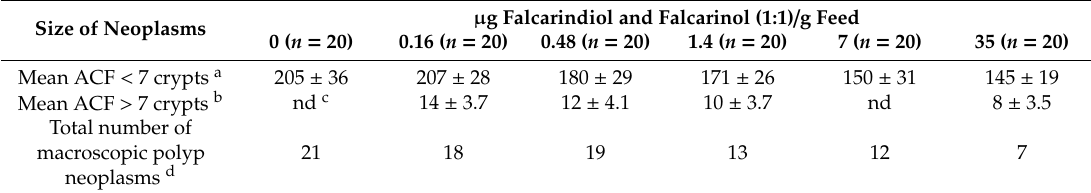
a Significant dose-response e ff ect according to linear regression analysis ( R 2 = 0.3742, P < 0.001). b Significant dose-response e ff ect according to linear regression analysis ( R 2 = 0.2451, P < 0.001). c nd = no data are available. d Dose-response relationship determined by Poisson regression with the number of macroscopic lesions decreasing by 0.167 for each log-fold increase in dose ( P =